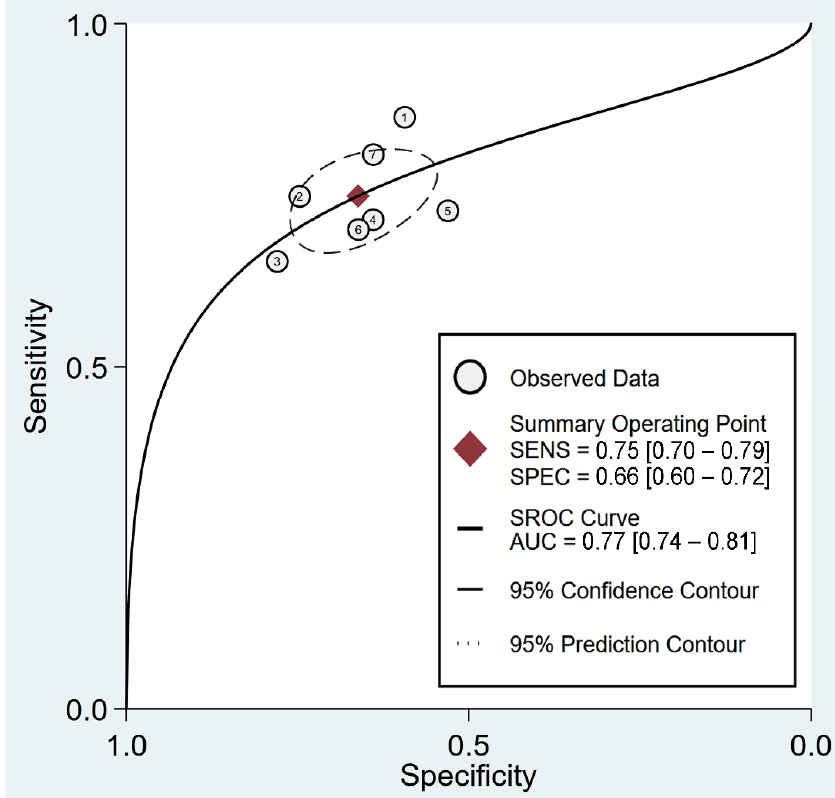
Figure 7. Hierarchical summary receiver operating characteristic (hsROC) curves of using fibrinogen-to-albumin (F/A) ratio for predicting in-hospital mortality among patients diagnosed with COVID-19 [12,25,32,34,35,37,38]. SENS, sensitivity; SPEC, specificity; SROC, summary receiver operating characteristic; AUC, area under the curve.